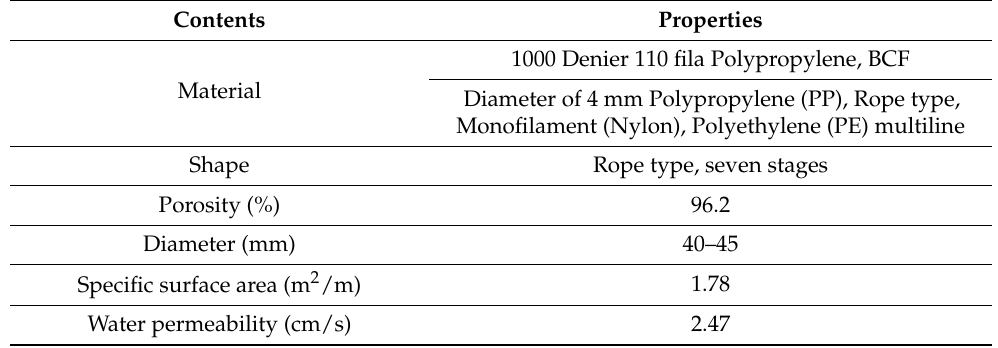
Table 3. Characteristics of fiber media filter.